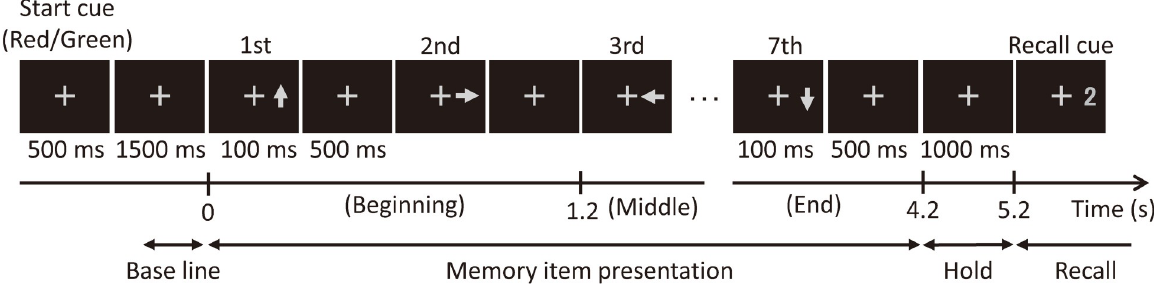
Fig 1. An example epoch of the sequential memory task. Each subject memorized the seven directional arrows pointing either left, right, up or down with 600 ms intervals in between each, and answered the direction of the arrow corresponding to the numeral of the recall cue. In this example, the correct answer is right (direction of the second